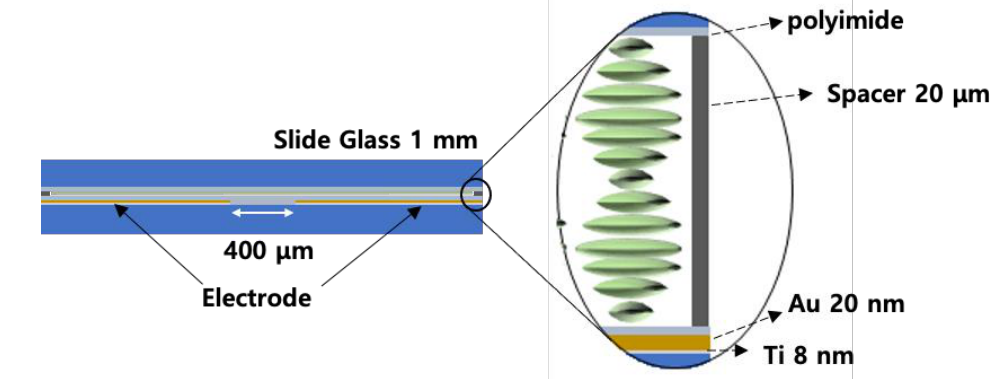
Figure 2. Structure of the CLC cell.